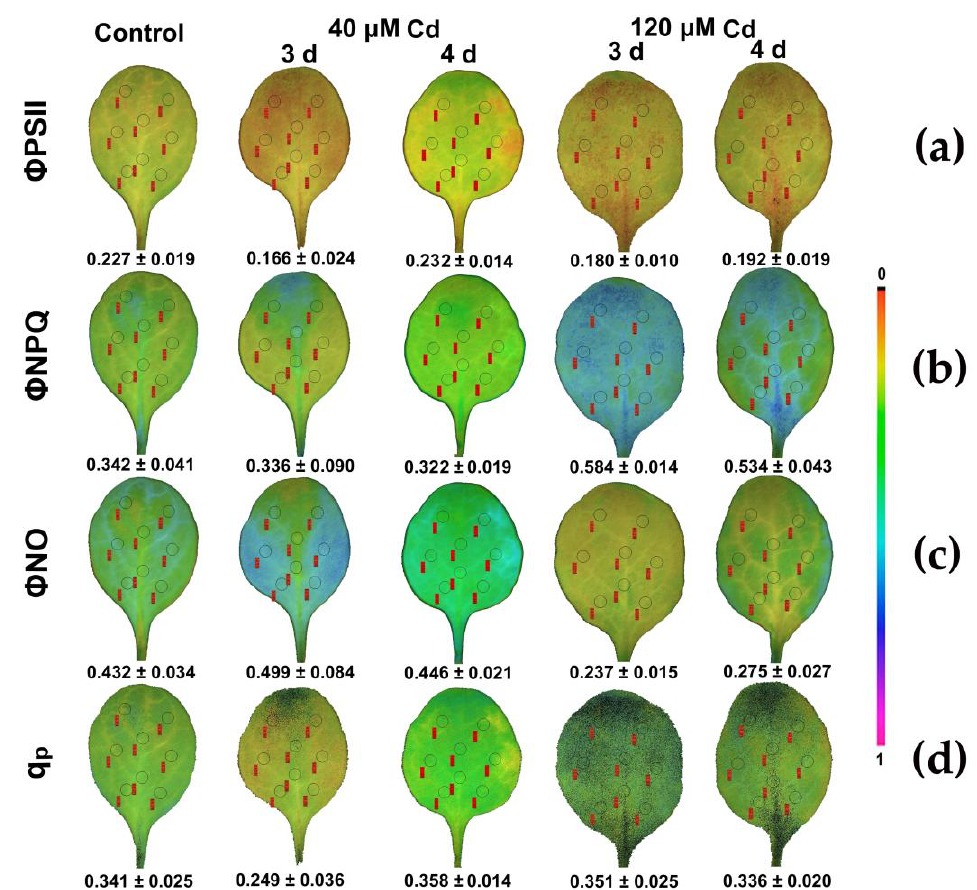
Figure 9. Representative chlorophyll fluorescence images after 5 min illumination at 1000 µ mol photons m − 2 s − 1 actinic light; of the actual (effective) quantum yield of PSII photochemistry ( Φ PSII ) ( a ), the quantum yield for dissipation by downregulation in PSII ( Φ NPQ ) ( b ), the quantum yield of non-regulated energy loss in PSII ( Φ NO ) ( c ), and the relative reduction state of Q A , reflecting the fraction of open PSII reaction centers ( q P ) ( d ) N. caerulescens plants were grown at 0 (control), 40 or 120 µ M Cd 2+ for 3 and 4 days. The colour code depicted at the right side of the images ranges from black (pixel values 0.0) to purple (1.0). The eight areas of interest are shown in each image. The average value of each photosynthetic parameter of the leaf is presented in the figure.